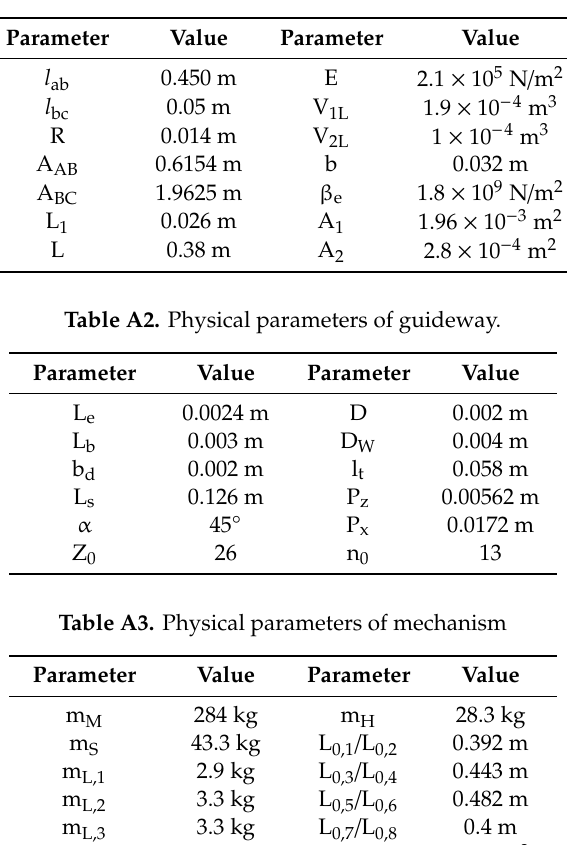
Table A1. Physical parameters of hydraulic motor.